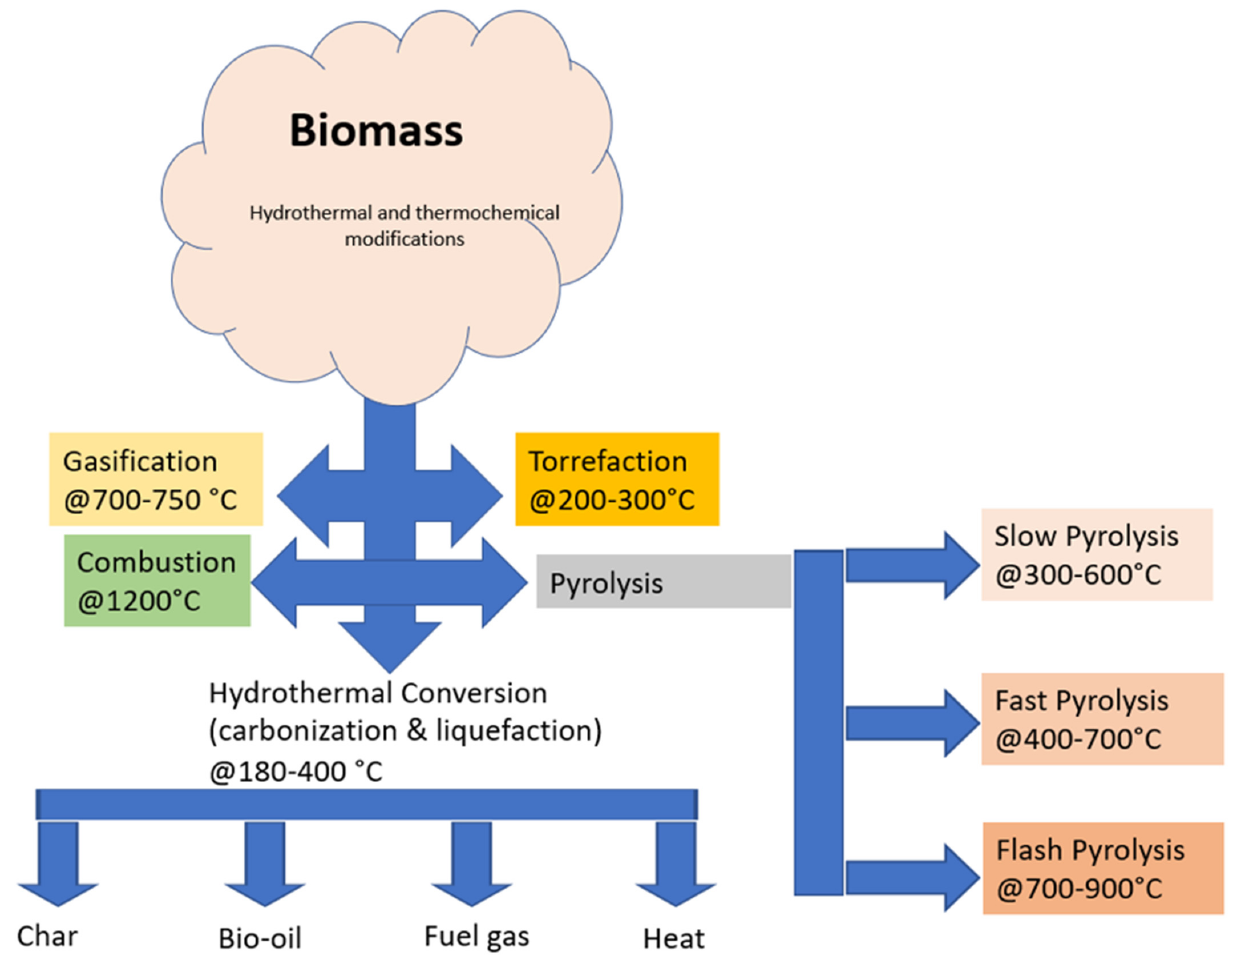
Figure 3. Thermochemical and hydrothermal conversion of biomass.